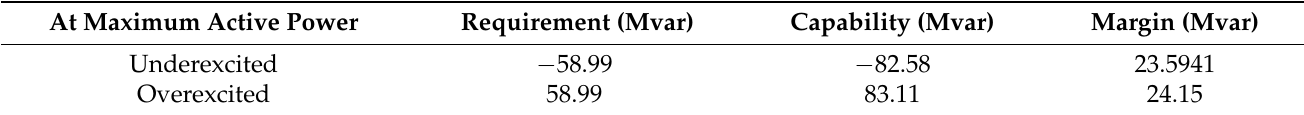
Table 2. Simulation results from the DIgSILENT model after correction using PPC set points.